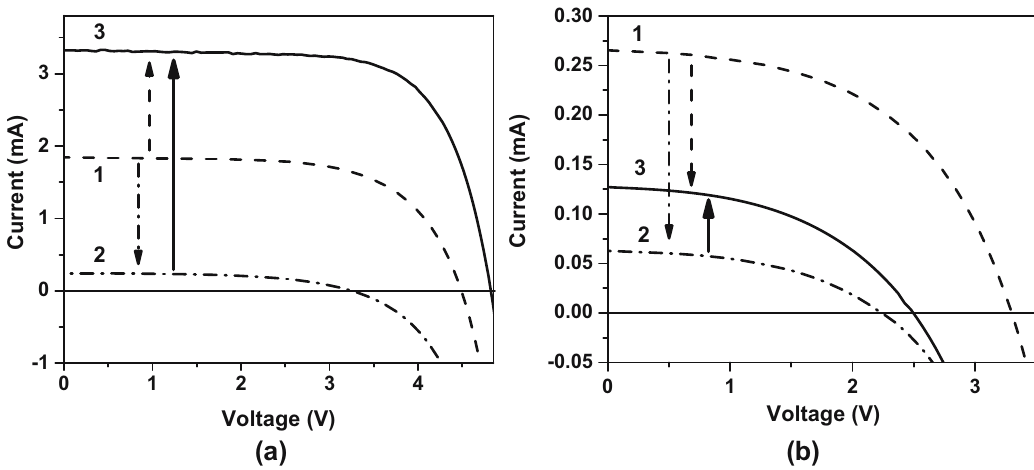
Figure 14: I – V characteristics of the LSC simulator. ( a ) LSC was illuminated with the solar simulator at 1.0 Sun. I – V characteristic 1 corresponds to the empty LSC; 2 – LSC fi lled with pure 1 - propanol, 3 – LSC fi lled with the NaY 0.83 F 4 :Yb 0.14 Er 0.03 nanocolloid in 1 - propanol. ( b ) LSC was illuminated with the 40 W light bulb. I – V characteristic 1 corresponds to empty LSC; 2 – LSC fi lled with pure 1 - propanol, 3 – LSC fi lled with the nanocolloid.